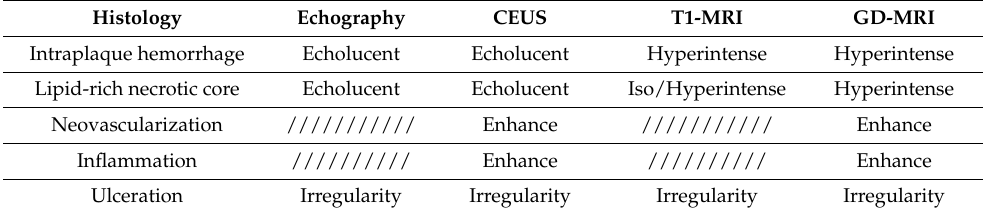
Table 1. Vulnerable plaque characteristics with different imaging.